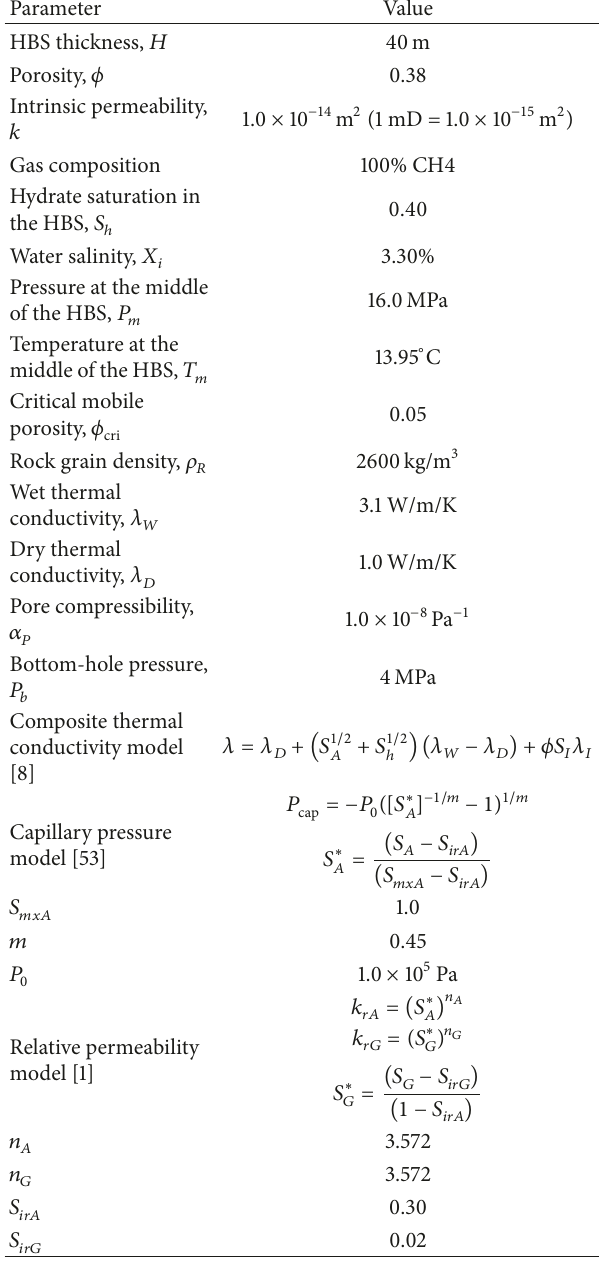
Table 1: Main model parameters of the HBS in Shenhu area of the